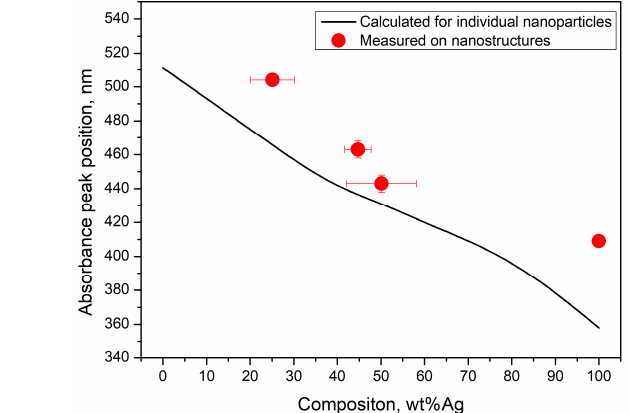
Figure 4. Normalized absorbance spectra of the samples S1–S5 ( left ), variation of the absorbance peak position measured on the samples and calculated for individual nanoparticles as a function of composition ( right ).